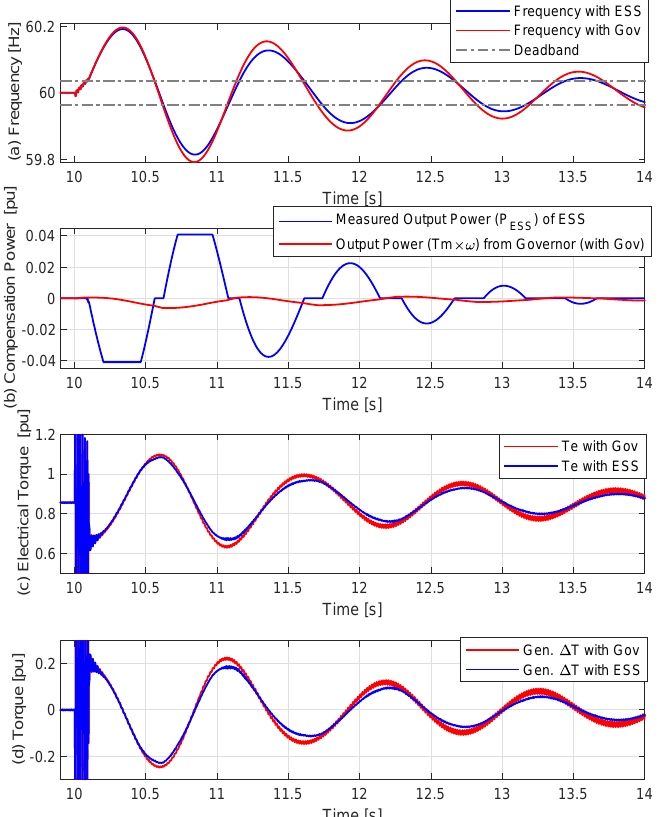
Figure 15. Permanent fault case with line trip; ( a ) generator frequency, ( b ) output power of ESS and Governor, ( c ) electrical torque of Generator, ( d ) torque deviation ( ∆ T ) of